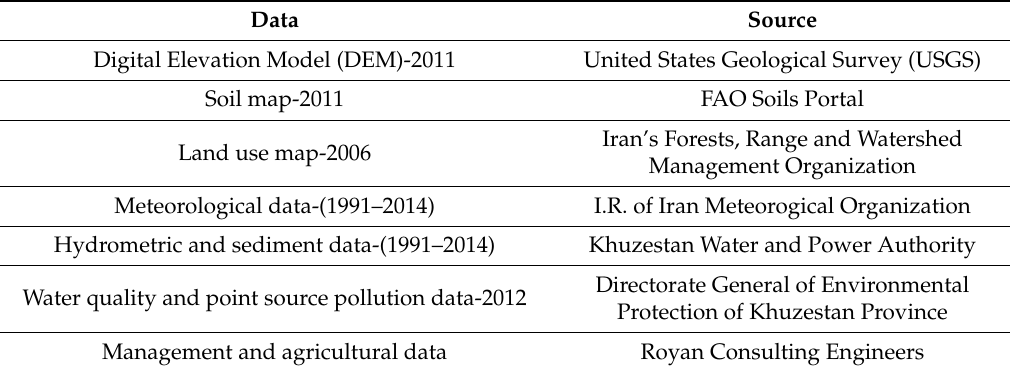
Table 1. The The Soil and Water Assessment Tool (SWAT) model input